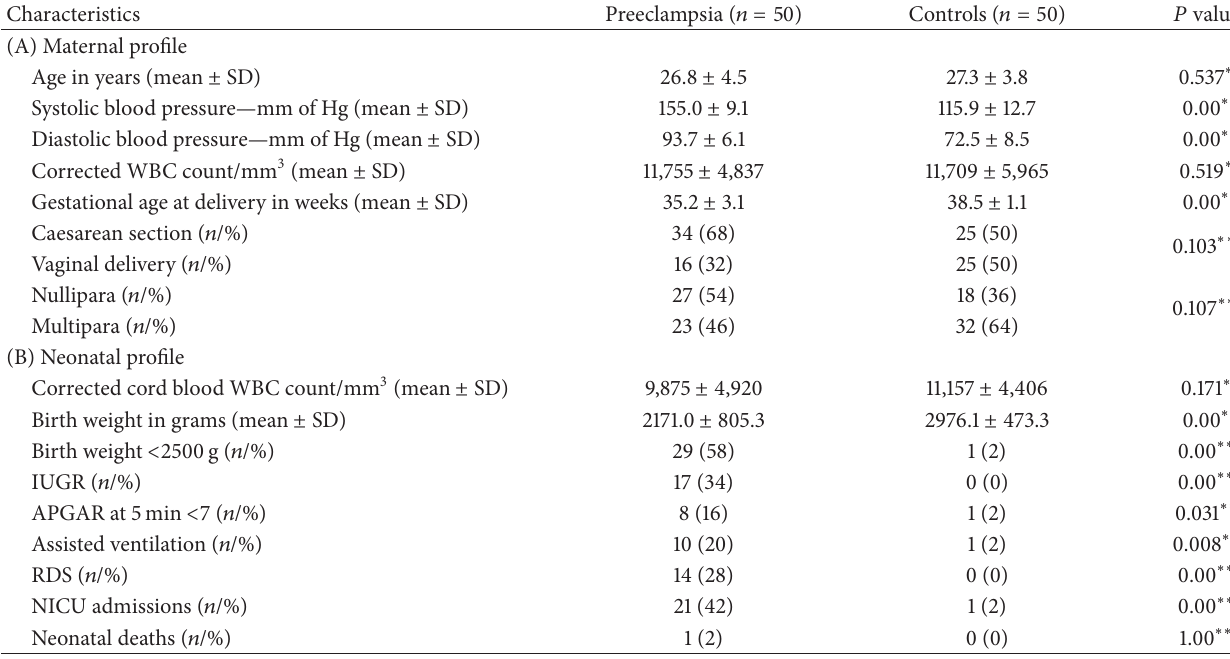
Table 1: Comparative study of maternal and neonatal characteristics in preeclampsia and control groups. Characteristics